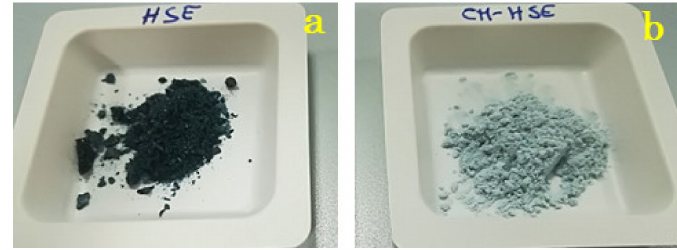
Figure 4. Macroscopic appearance of HSE raw material ( a ) and CM-HSE( b ).